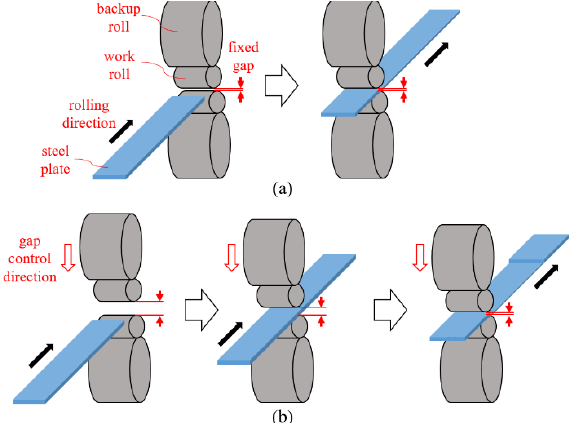
Figure 1. ( a ) Conventional hot rolling method in finishing mill; ( b ) hot rolling in finishing mill using flying touch method.